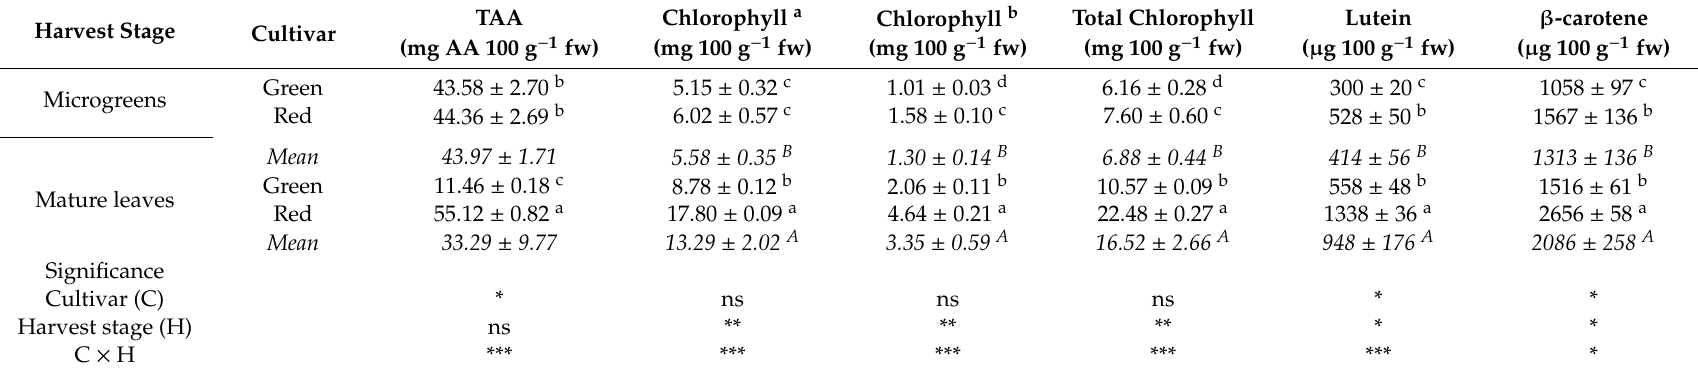
Table 2. Total ascorbic acid (TAA), chlorophyll, lutein and β -carotene content of green and red Salanova butterhead lettuce as influenced by harvest